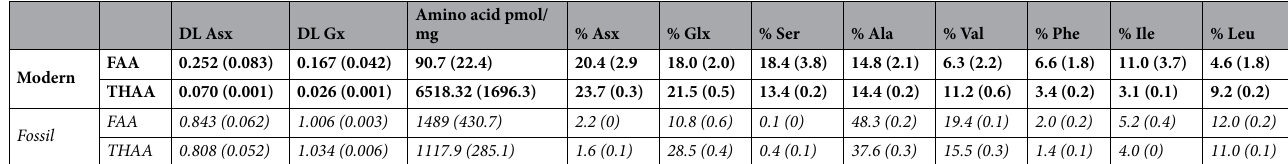
Amino acid pmol/ DL Asx DL Gx mg % Asx % Glx % Ser % Ala %